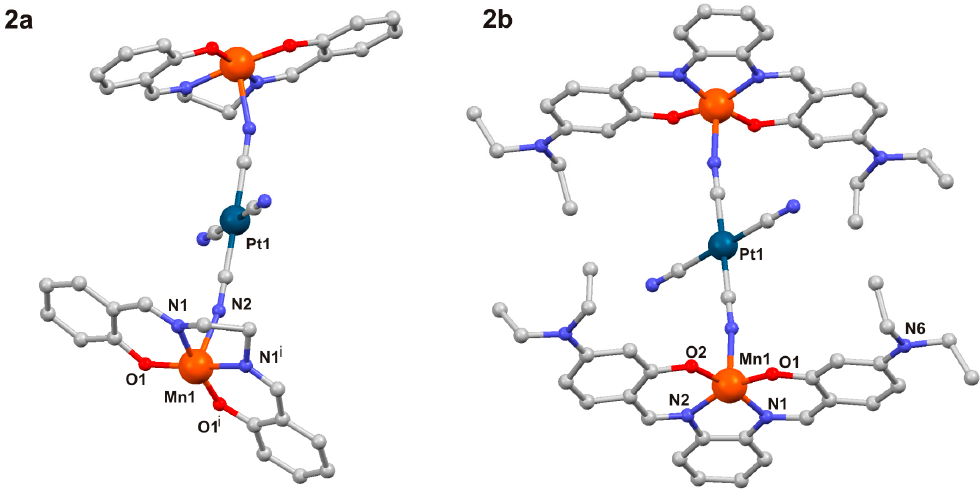
Figure 1. Part of crystal structure of 2a ( left ) and molecular structure of 2b ( right ). Hydrogen atoms are omitted due to clarity. Selected bond lengths (in Å) and angles (°): 2a : Mn1 − N1 = 1.963(9), Mn1–N2 = 2.279(8), Mn1 − O1 = 1.888(6), O1–Mn1–N1 = 173.1(3), N2–Mn1–N2 i = 174.0(4), [Symmetry code: